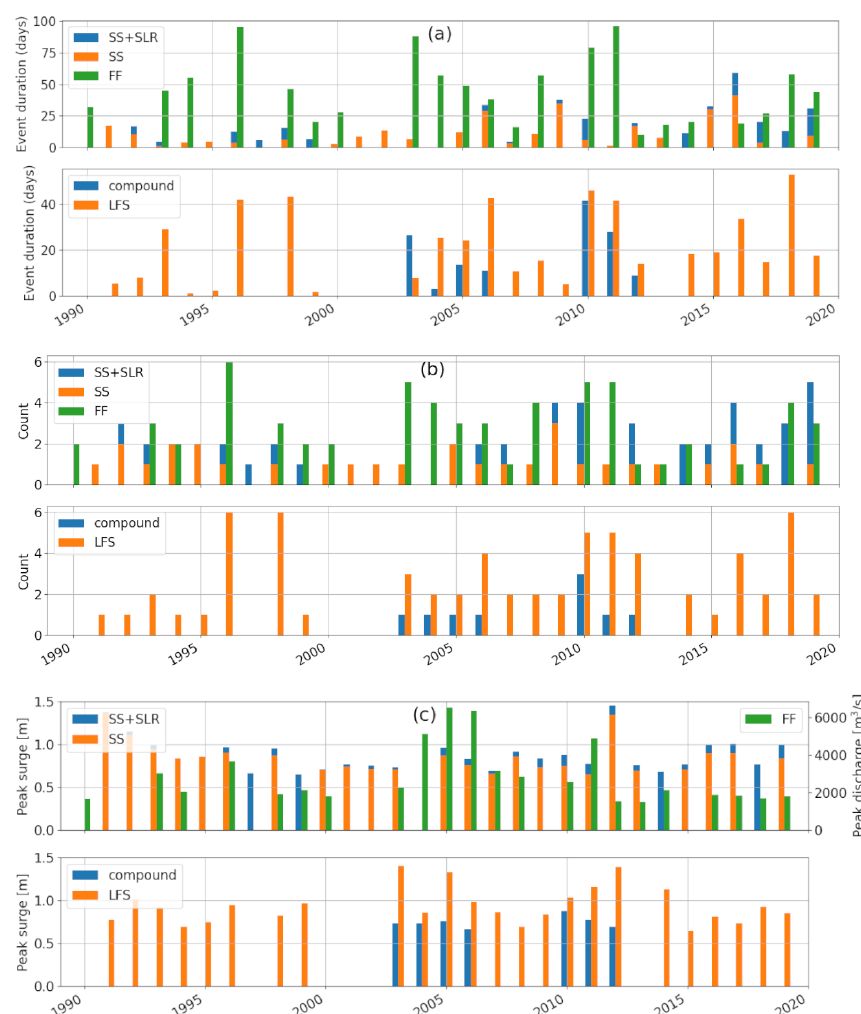
Figure 12. The interannual variability of (a) the event annual duration, (b) the event occurrence and (c) the maximum peak value for different types of flood events.